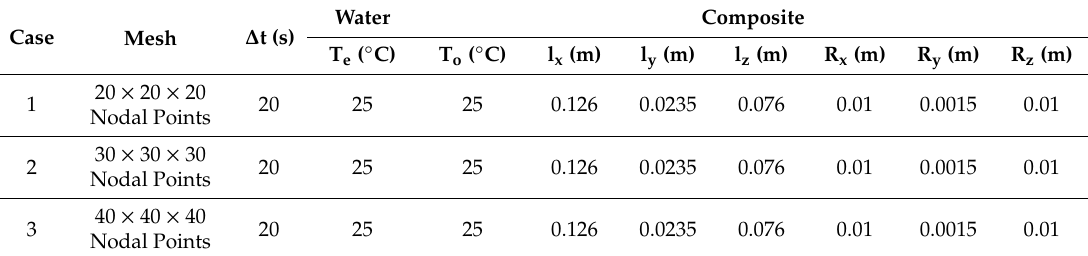
Table 1. Cases studied for selecting an appropriated numerical mesh.